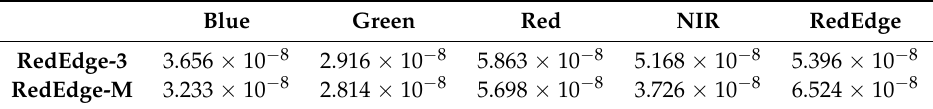
Table 3. Radiometric calibration coefficients computed using proposed methodology for both RedEdge-3 and RedEdge-M sensors. The Blue, Green and Red bands produced very similar coefficients, while the NIR and RedEdge bands were